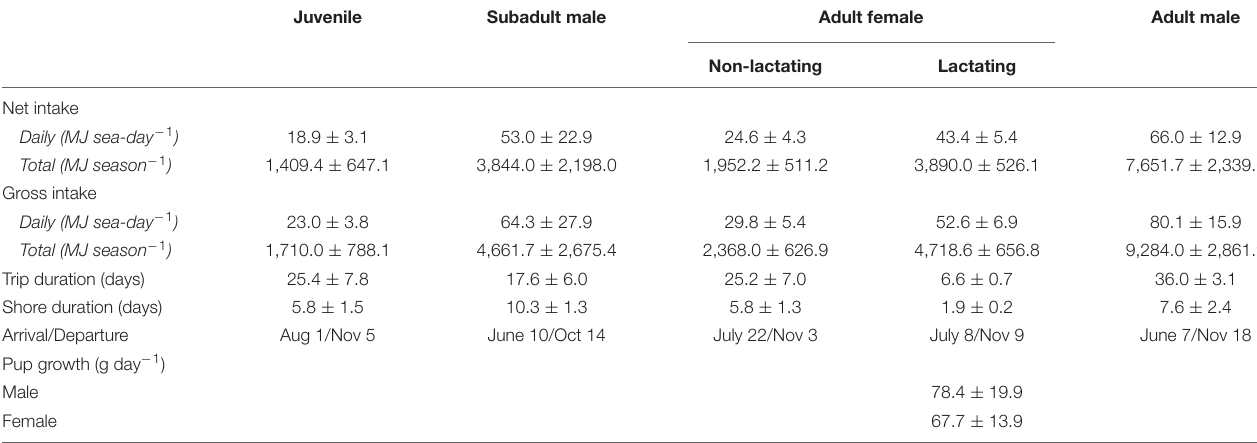
TABLE 1 | Summary statistics from the bioenergetic model simulations, including the mean ( ± SD ) net and gross energy intake, trip duration, shore duration, arrival and departure dates in the Bering Sea, and pup growth rates.